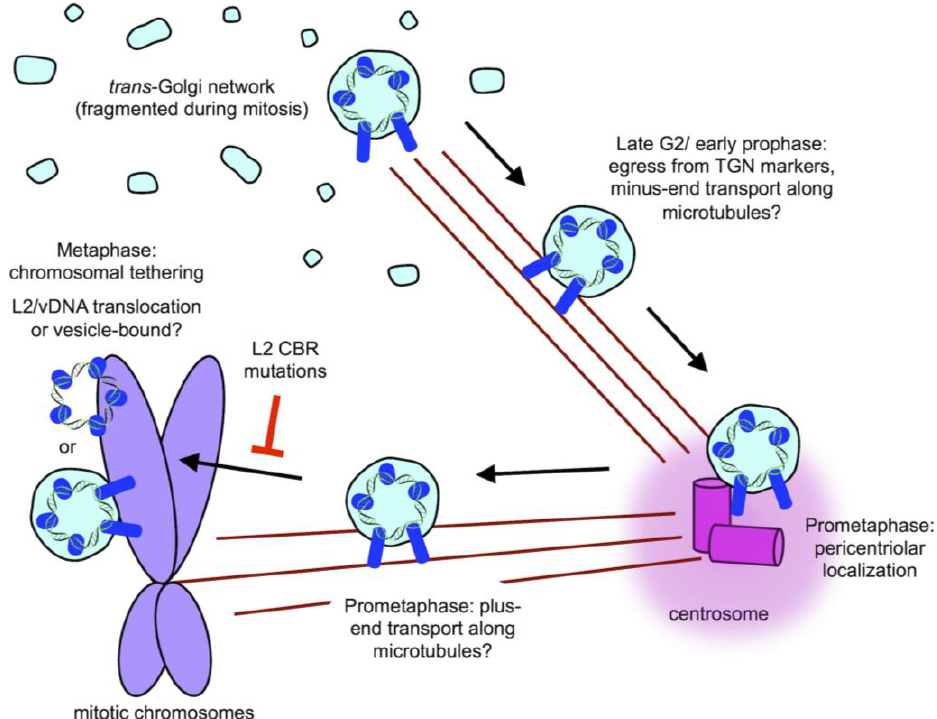
Figure 3. Post-TGN mitotic trafficking of L2/vDNA complex. Upon entry into mitosis, L2/vDNA remains vesicle-bound but loses coincidence with TGN markers. These L2/vDNA-containing vesicles likely travel along astral microtubules in the minus-end direction towards the centrosome, where they accumulate during prometaphase. The vesicles likely switch polarity and travel along the spindle microtubules in the plus-end direction to reach the host chromosomes by metaphase. Chromosome-bound L2/vDNA partitions with host chromosomes, eventually localizing to PML bodies of the daughter cells. Chromosome binding of L2/vDNA is through the chromatin binding region (CBR) of L2 and mutation of this region causes a block in translocation, with vesicular L2/vDNA becoming reabsorbed back into the nascent Golgi after mitosis. Chromosome-bound L2/vDNA may be in a membrane-bound vesiclular state, or may have penetrated the limiting membrane upon chromosome binding, further work is needed to clarify this stage of the HPV life cycle.